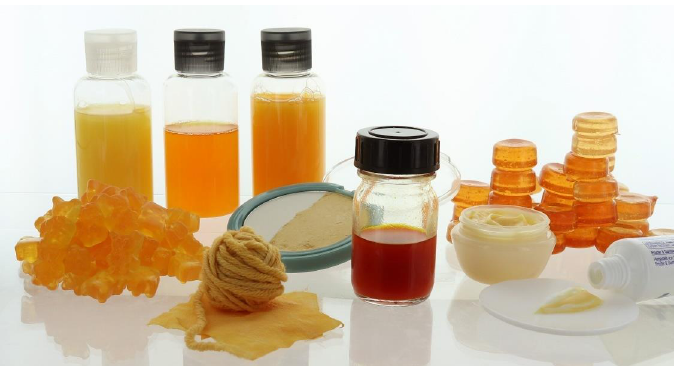
Figure 6. Ethanolic extract of submerged cultivated L. sulphureus (bottle in the middle) used for application trials. From left to right: Jelly gum, soap, transparent and opaque shampoo, wool and silk, powder, hard candy, body lotion, toothpaste.